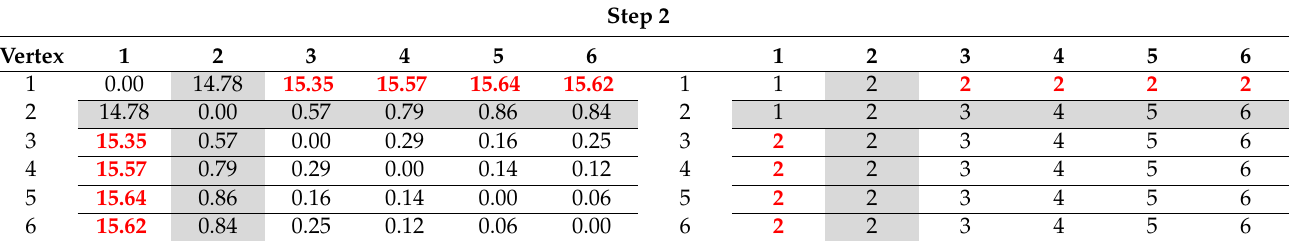
Table A2. The step 2 graphical process of Floyd–Warshall algorithm.